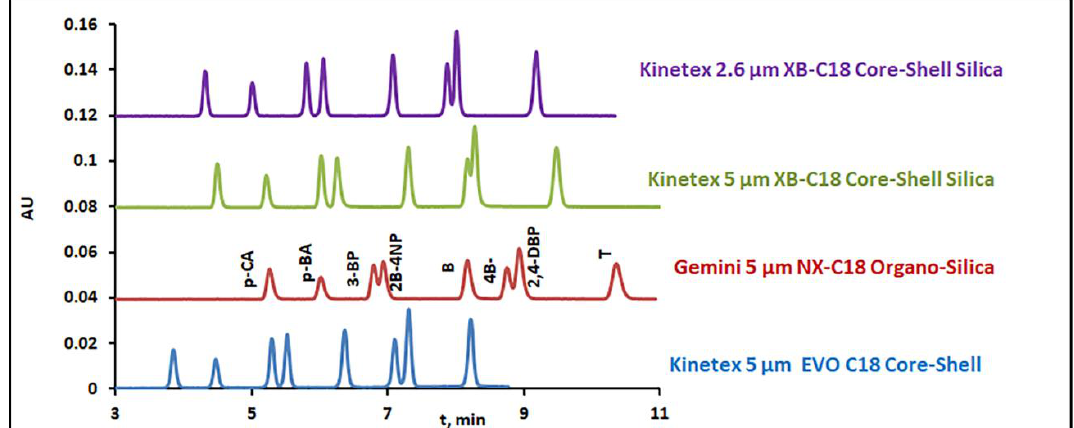
Figure 5. UV detected chromatograms of the mixture of 8 ionized and non-ionized solutes obtained on different columns under optimal gradient conditions found for eluent pH = 3 and Kinetex 5 µm EVO column. The elution order of solutes is shown in the Figure. See Table 1 for details of optimal gradient conditions.